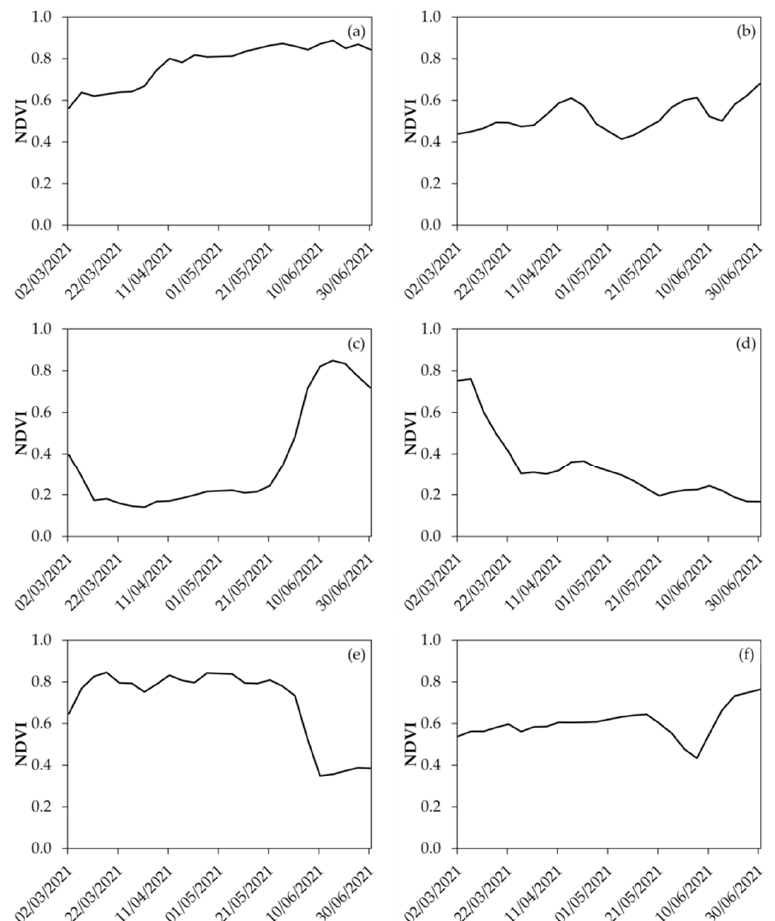
Figure 3. NDVI temporal profiles (field averaged) for: ( a ) Ecological Forest Area profiles; ( b ) mowed meadow profile; ( c ) profile related to sowing and crop development; ( d ) profile showing a possible harvesting at the beginning of the controlled period; ( e ) profile showing a possible harvesting at the end of the period; and ( f ) profile showing a significant agronomic operation in the middle of the controlled period.